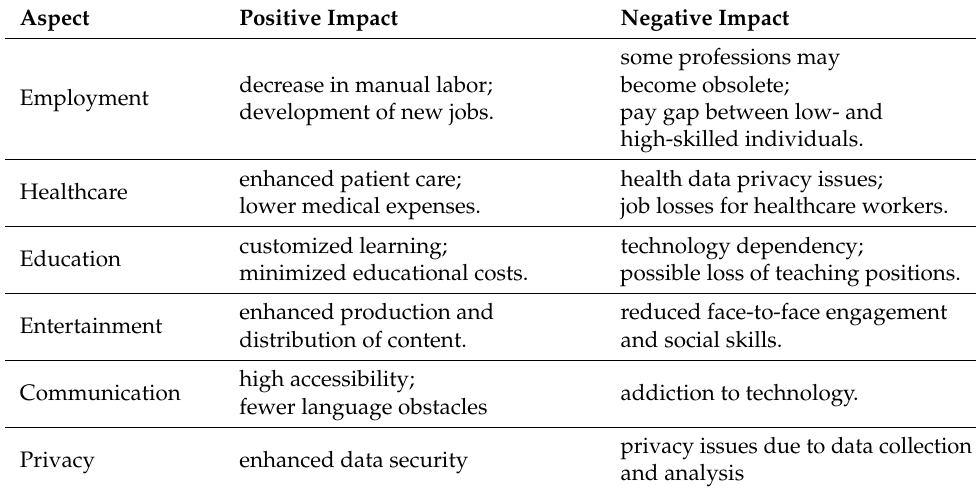
Table 13. The positive and negative aspects of society effected by AI as a disruptive technology.